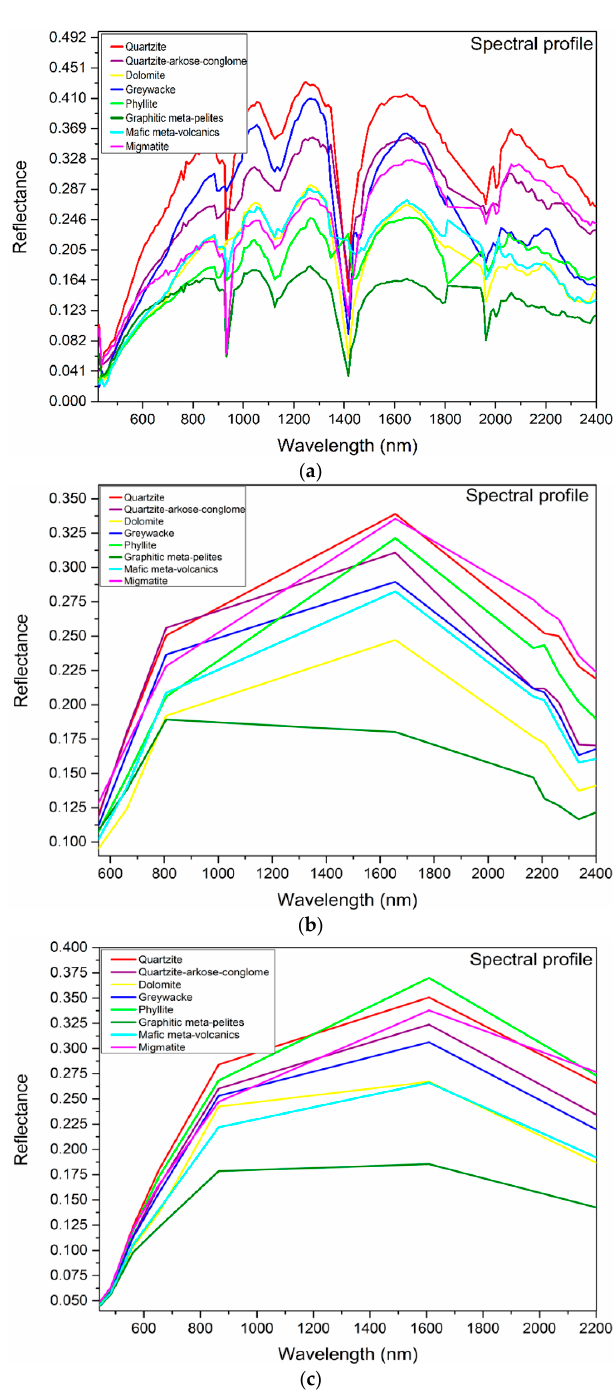
Figure 4. Average reflectance spectra of training samples from different rock units from exposed terrain from Hyperion image ( a ), ASTER image ( b ), and Landsat 8 image ( c ).